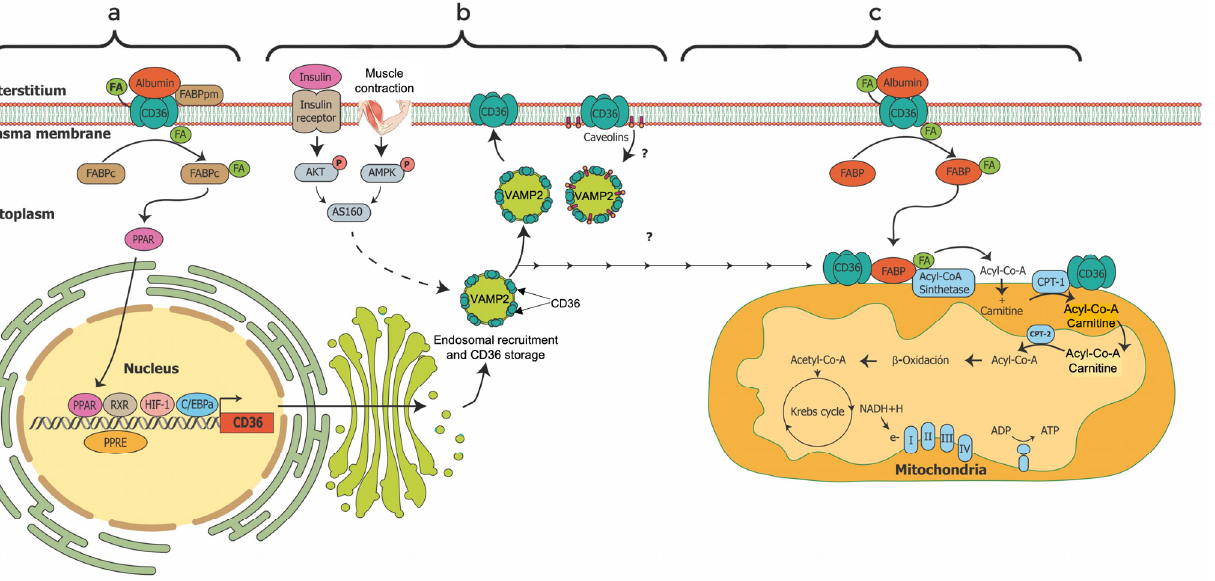
Figure 5. ( a ). Regulation of FAT/CD36 expression. Fatty acids (Fas) internalized into the cytosol are natural ligands of the PPAR transcription factor; this interaction leads to its activation, a condition that induces the transcription of FAT/CD36 through the formation of a heterodimer with “PPAR response element (PPRE)”, the “retinoid X receptor (RXR)”. Additionally, other transcription factors can exert transcriptional control, such as HIF-1 and C/EBP α . ( b ). Diagram illustrating the feedback of FAT/CD36 expression in musculoskeletal tissue. Under resting conditions, FA internalization induces FAT/CD36 synthesis through the molecular mechanism regulated by the transcription factor PPAR. FAT/CD36 is transported across the endomembrane system and ultimately stored in endo-